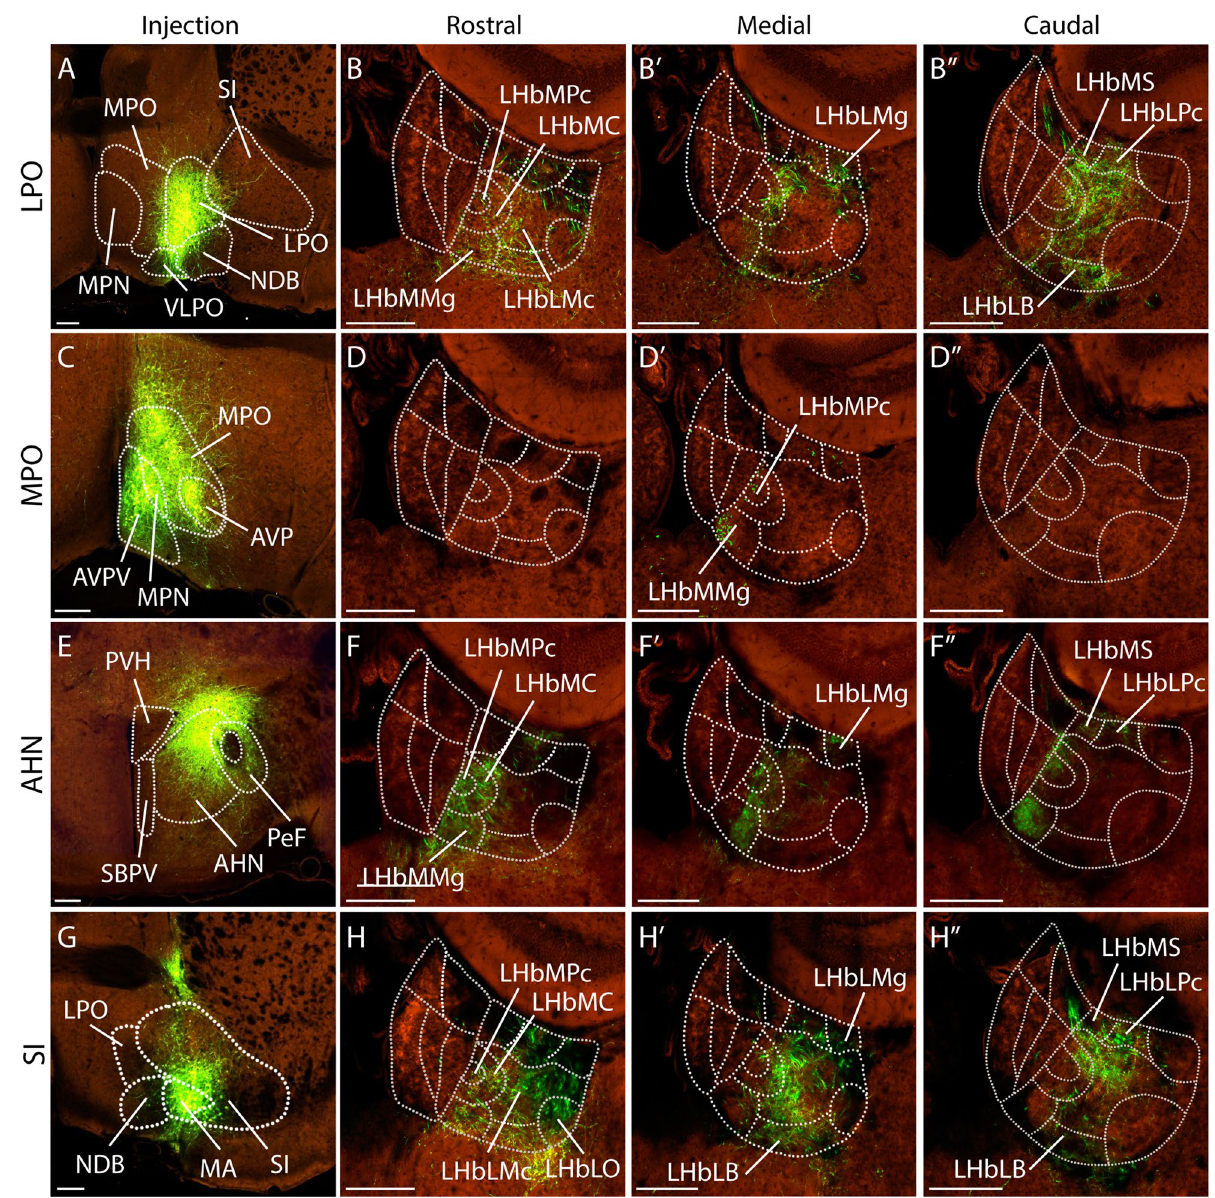
Figure 4. Preoptic area, terminal hypothalamic and pallidal projections to the LHb. ( A ) Injection site in the lateral preoptic area (LPO; Experiment nº: 293,942,188). ( B – B ”) Adult mouse habenula coronal sections, from rostral to caudal, showing the fibers distribution originated from the LPO nucleus. ( C ) Injection site in the medial preoptic area (MPO; Experiment nº: 299,247,009). ( D – D ”) Adult mouse habenula coronal sections, from rostral to caudal, displaying the fibers distribution coming from the MPO nucleus. ( E ) Injection site in the anterior hypothalamic nucleus (AHN; Experiment nº: 292,035,484). ( F – F ”) Adult mouse habenula coronal sections, from rostral to caudal, showing the fibers distribution originated from the AHN nucleus. ( G ) Injection site in the substantia innominata (SI; Experiment nº: 302,739,608). ( H – H ”) Adult mouse habenula coronal sections, from rostral to caudal, showing the fiber distribution originated from the SI nucleus. Abbreviations: AHN: anterior hypothalamic nucleus; AVPV: anteroventral periventricular nucleus; AVP: Anteroventral preoptic nucleus; LHb, lateral habenula; LHbLB: LHbL basal subnucleus; LHbLMc: LHbL magnocellular subnucleus; LHbLMg: LHbL marginal subnucleus; LHbLO: LHbL oval subnucleus; LHbLPc: LHbL parvocellular subnucleus; LHbM: LHb medial territory; LHbMC: LHbM central subnucleus; LHbMMg: LHbM marginal subnucleus; LHbMPc: LHbM parvocellular subnucleus; LHbMS: LHbM superior subnucleus;